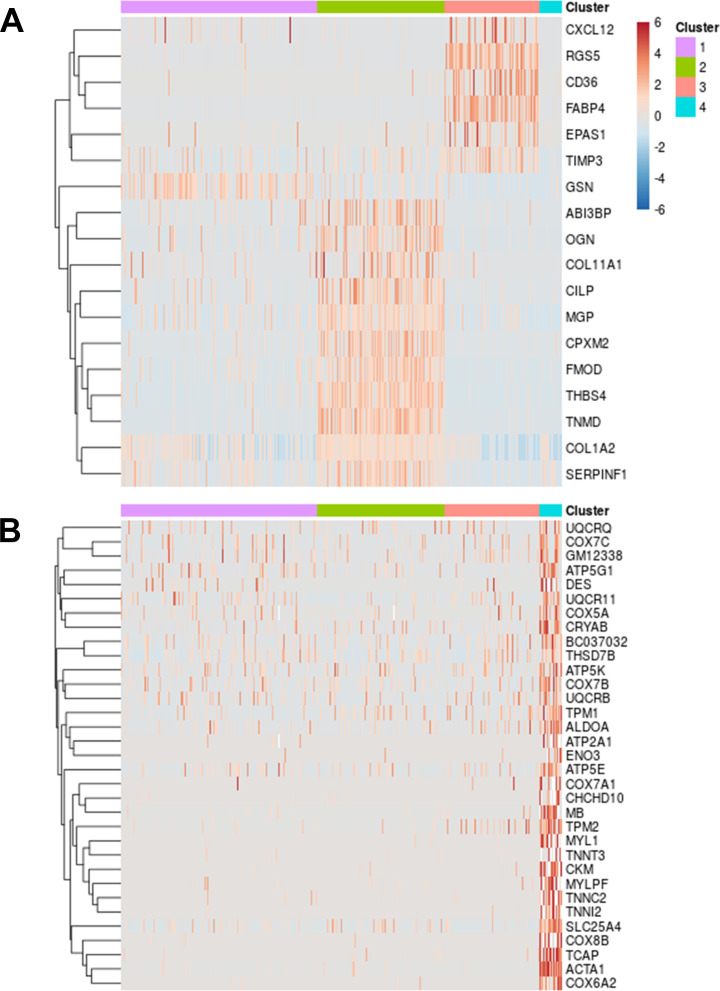
Heat maps of cluster markers.Heat map indicating expression of cluster markers with area under the receiver operating characteristics curve (AUROC) values >0.7 for (A) clusters 1–3 which appear to be periosteal populations and (B) cluster 4 which shows expression of skeletal muscle lineage genes.